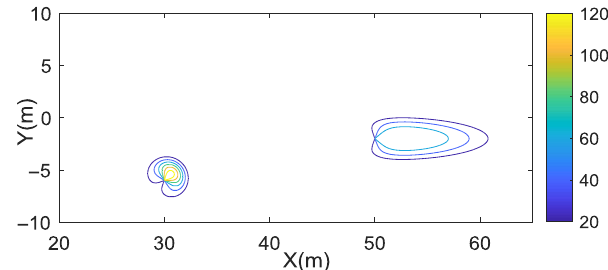
Figure 4 Risk assessment of dynamic